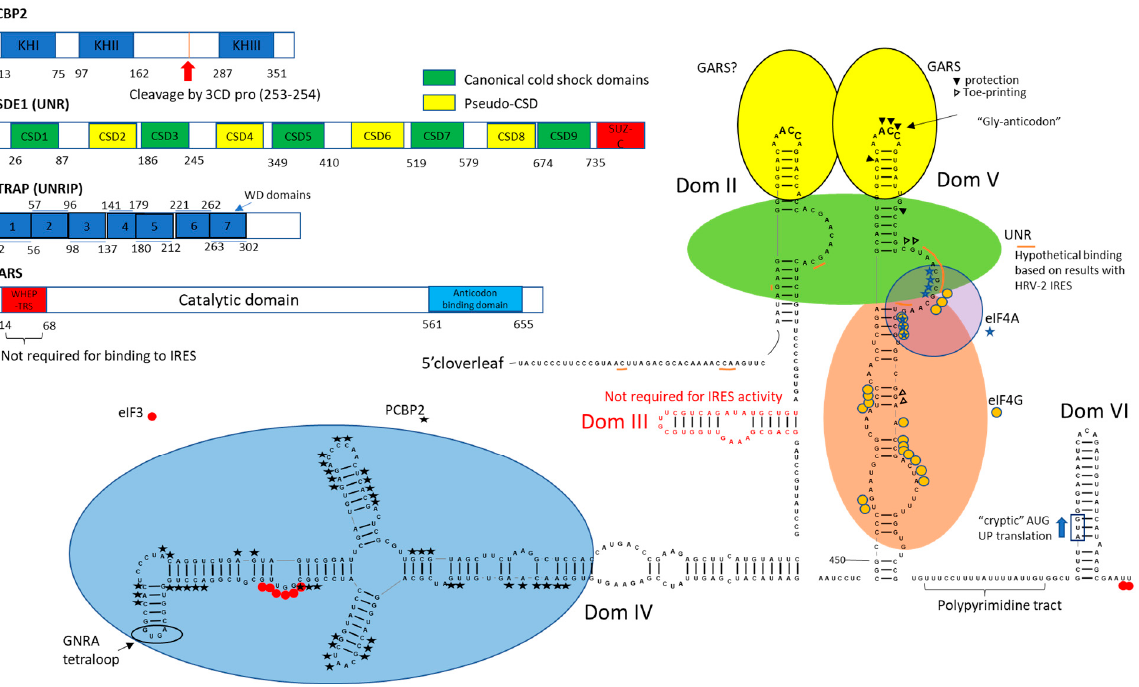
Figure 1. Domain organization of ITAFs involved in type I IRES-driven translation. Secondary struc- ture of PV IRES (Mahoney strain) with highlighted functionally important sequences. Nucleotides that are protected or modified in the presence of selected proteins are marked. Note that while there is no direct evidence regarding UNR binding site on PV IRES, an approximation was made from the data obtained for the HRV-2 IRES.